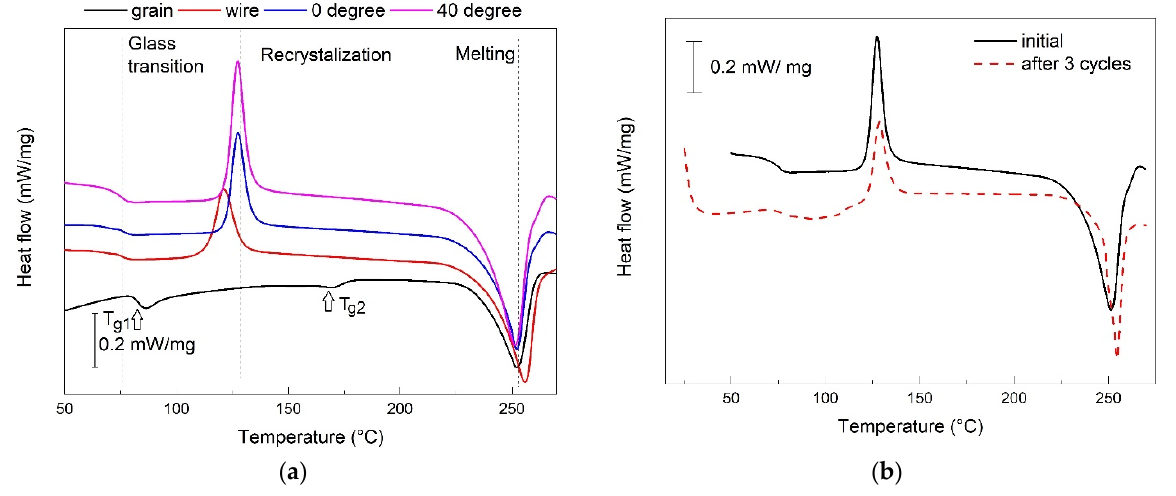
Figure 6. DSC thermograms recorded during heating: ( a ) R-PET grain, filament and printed speci- mens at 0° and 40°; ( b ) printed specimen at 40° in an initial state and after three free-recovery SME imens at 0 ◦ and 40 ◦ ; ( b ) printed specimen at 40 ◦ in an initial state and after three free-recovery cycles. SME cycles. Table 2. Evaluation results of the thermograms from Figure 6. Glass Specimen